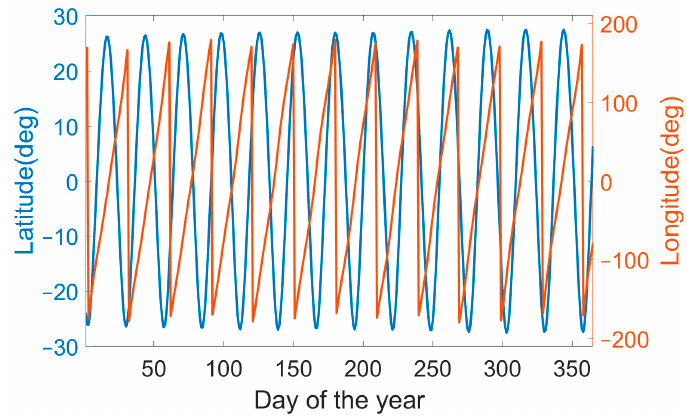
Figure 7. Latitude and longitude of sublunar points over 2022.